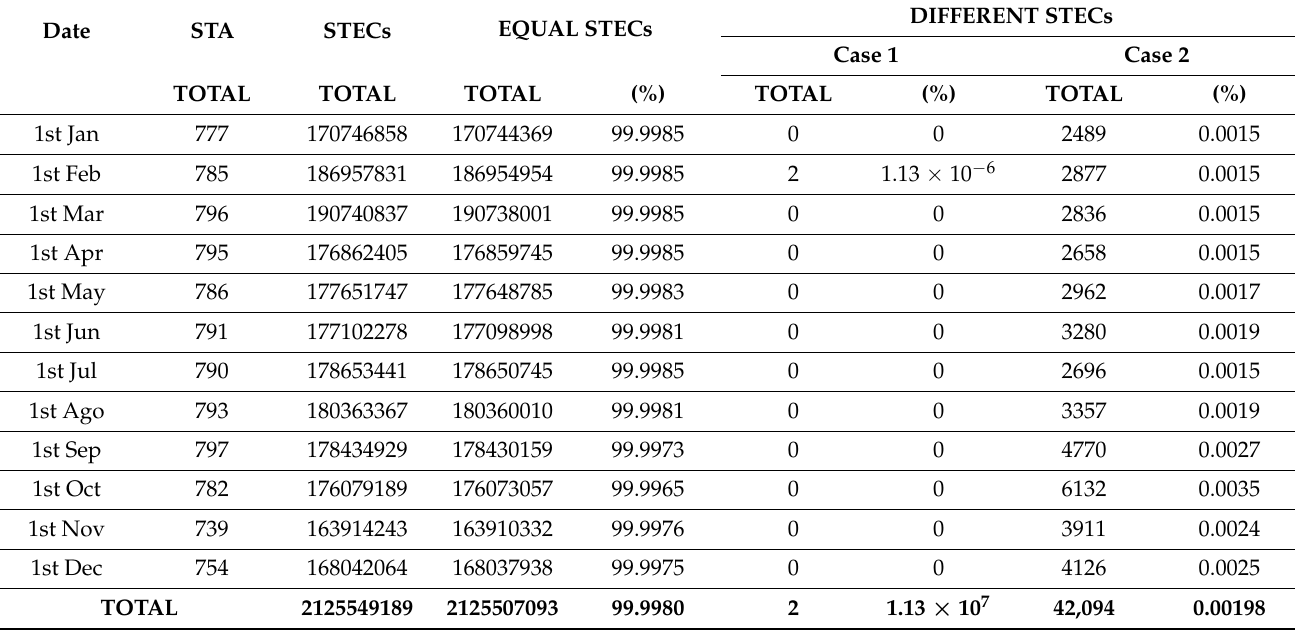
Table 2. Details of the comparison between ESA and JRC libraries implementations. For every day assessed within 2019, we count the total number of stations and STECs, specifying the number of equal STECs and the different STECs for the discrepancy types detailed in Section